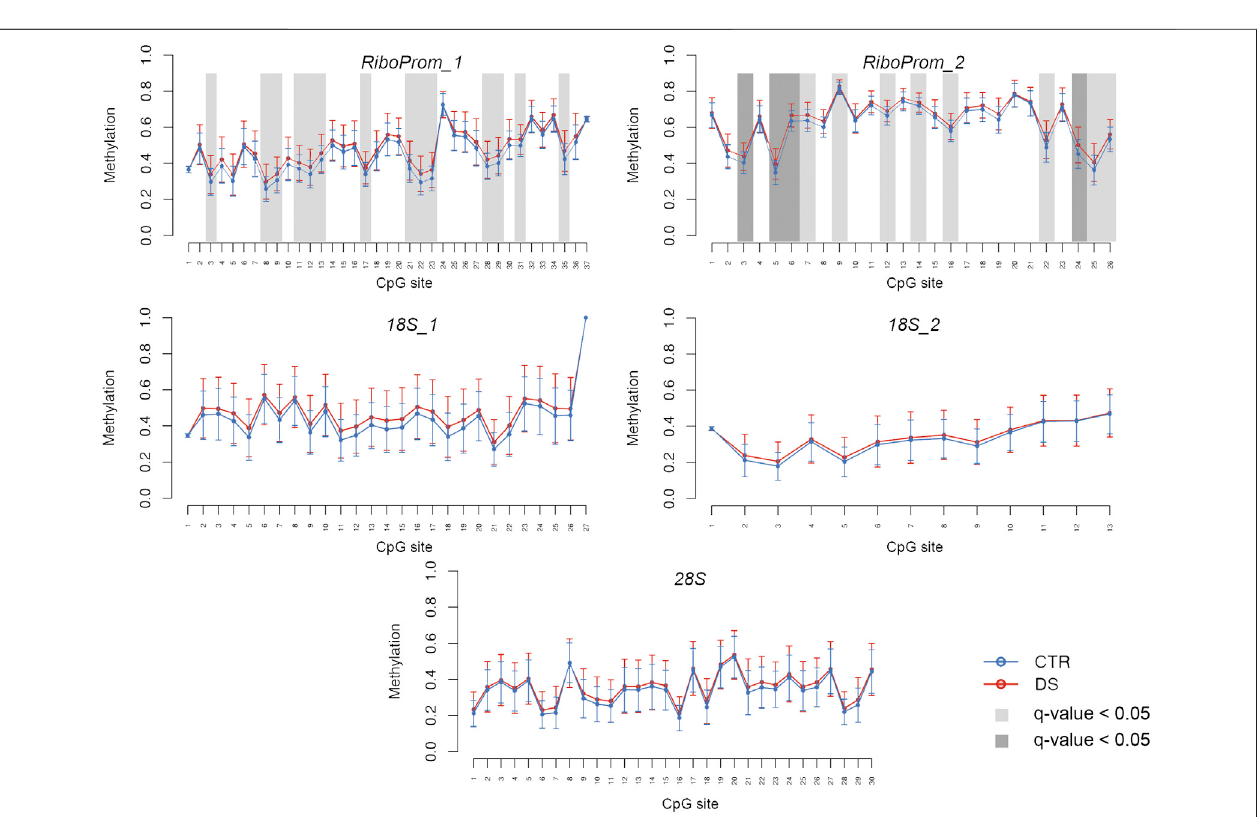
FIGURE 2 | DNA methylation pro fi les of rDNA target regions in persons with DS. For RiboProm_1, RiboProm_2, 18S_1, 18S_2, and 28S target regions, the plots show mean DNA methylation and standard deviation in persons with DS and controls. Differential methylation was calculated using ANOVA and correcting for age, sex, and batch. CpGs with q.value < 0.01 are highlighted with dark gray boxes; CpGs with q-value < 0.05 are highlighted with light gray boxes.